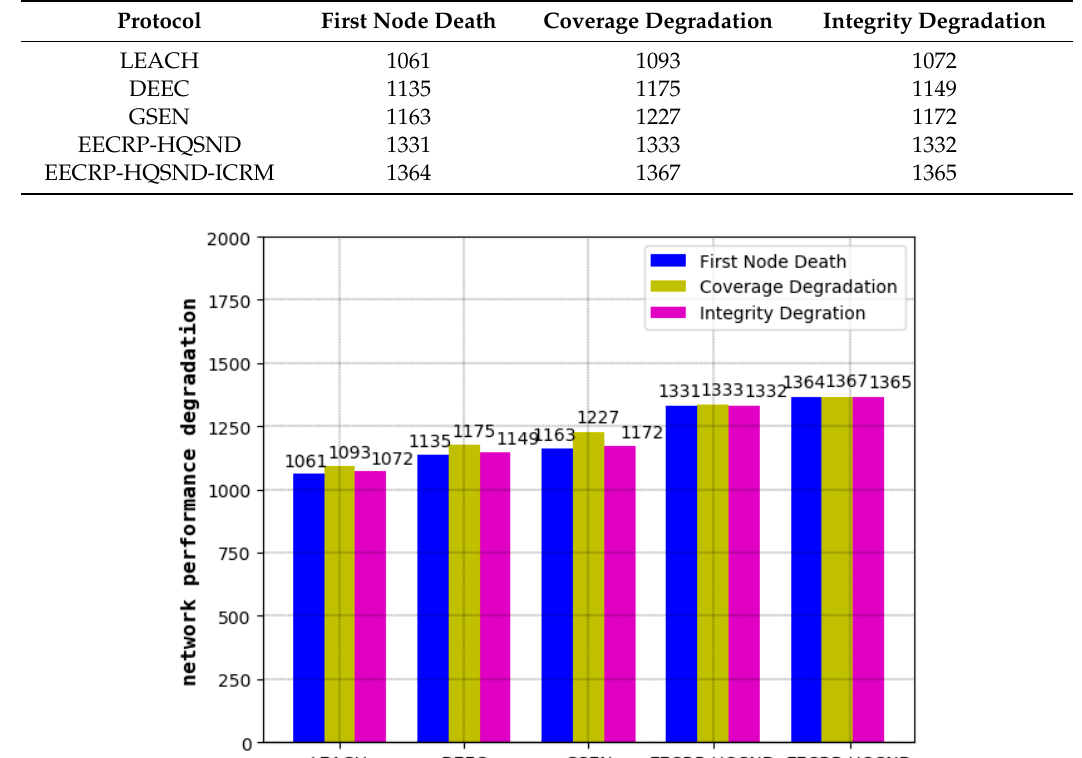
Table 3. Comparison of the number of rounds leading to decline in the network for each protocol.